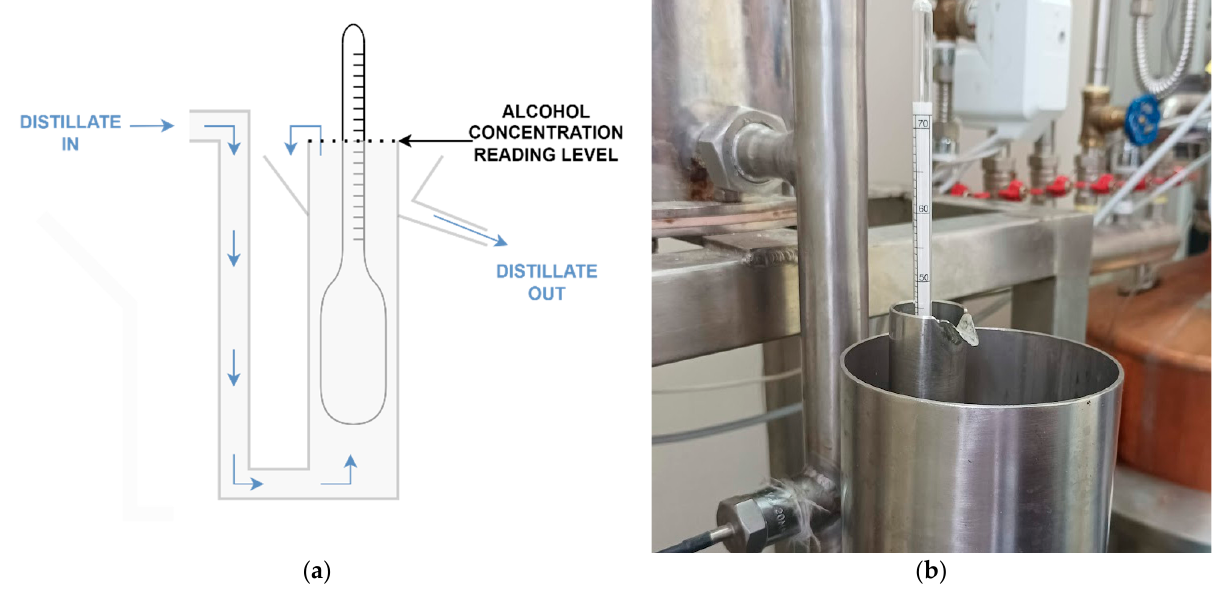
Figure 3. Structure of still parrot. ( a ) Illustration of parrot cross-section with distillate flow labeled with blue arrows and alcohol concentration reading level. Alcohol concentration is read from scale on alcoholmeter in place where it meets surface of the distillate; ( b ) one realization of parrot for measuring alcohol concentration during distillation.